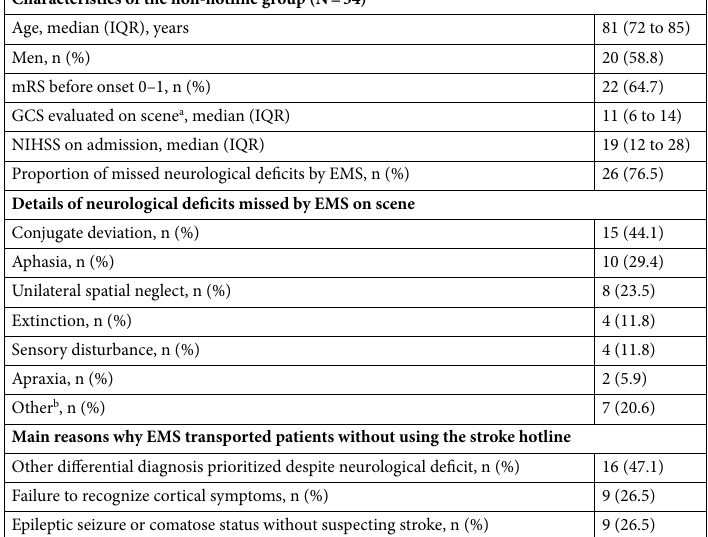
Main reasons why EMS transported patients without using the stroke hotline Other differential diagnosis prioritized despite neurological deficit, n